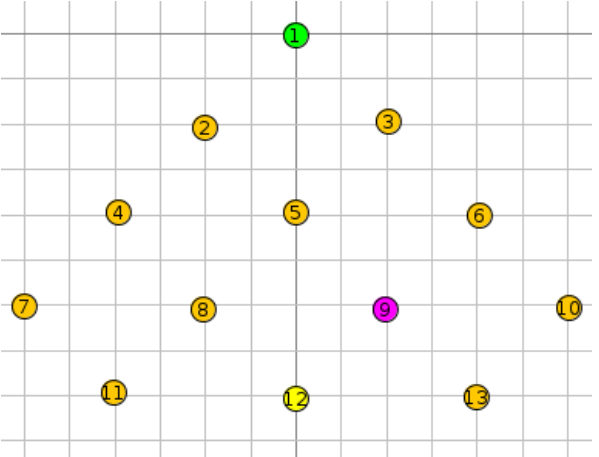
Figure 10. Version number attack detection simulation topology. Node 1 is the central IDS. Node 9 is an IDS detector. Node 12 is the version number attacker. The rest of the nodes are dummy